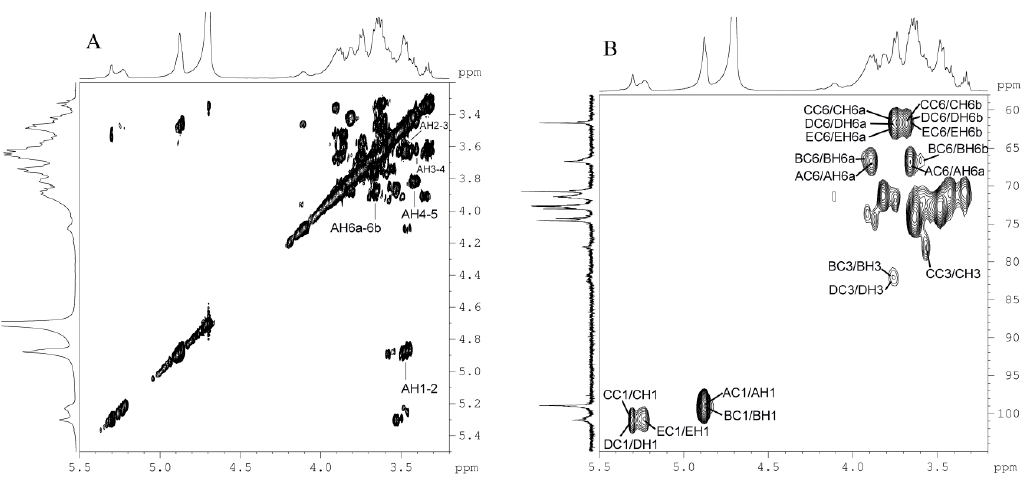
Figure 5. 2D-NMR spectrum of BP1. ( A ) 1H-1H COSY spectra of BP1; ( B ) HSQC spectra of BP1. The cross-peaks are labelled with the residue and number; residue names are the same as those in Table 2.